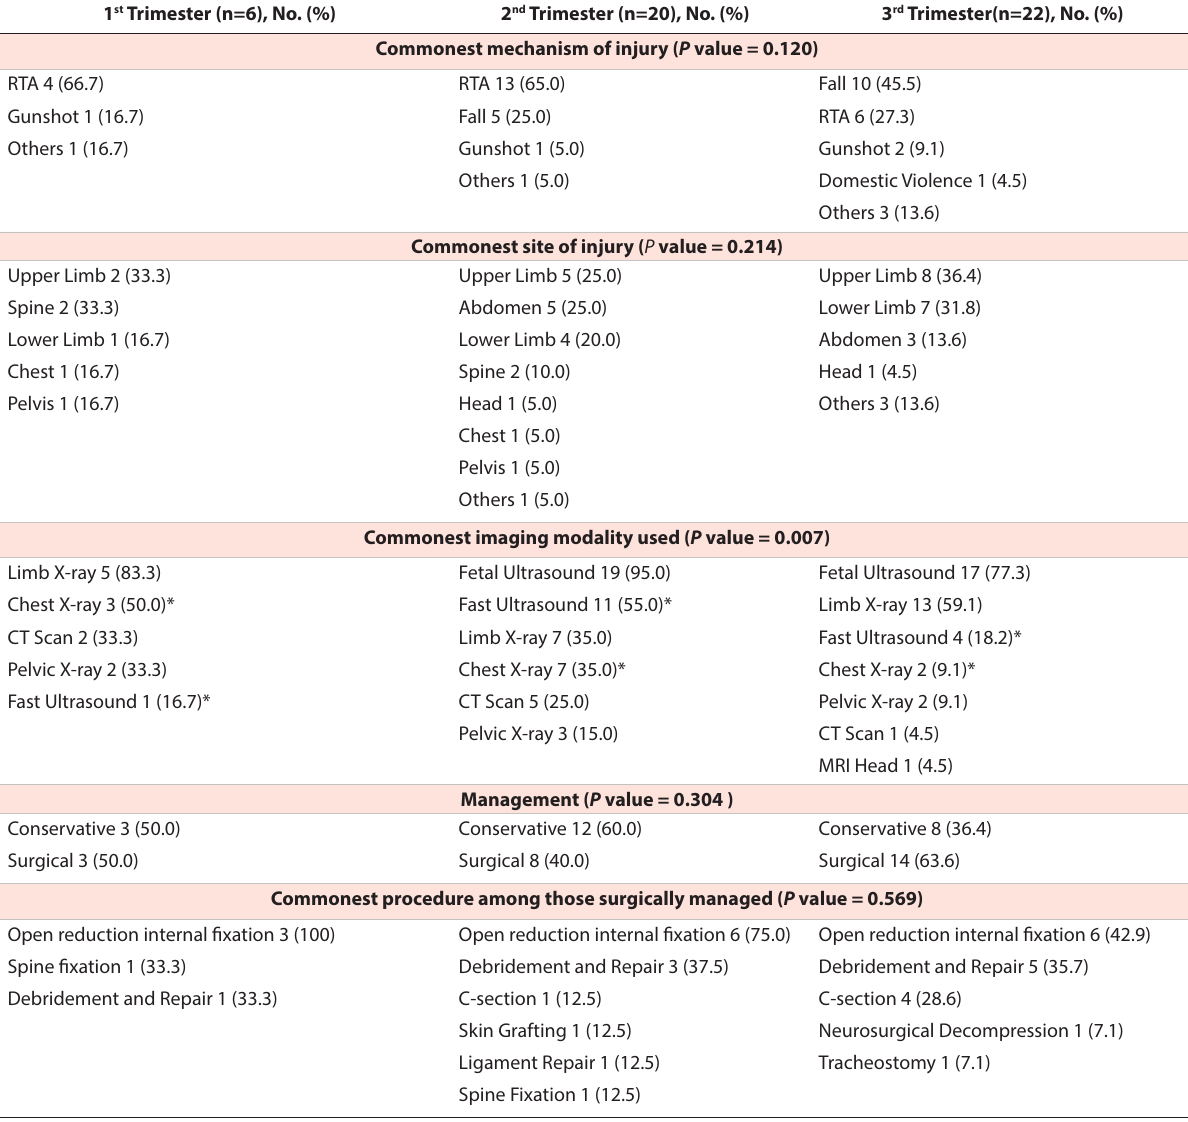
Table 2. Commonest injury patterns, imaging modalities and management according to trimesters 1 st Trimester (n=6), No. (%) 2 nd Trimester (n=20), No.